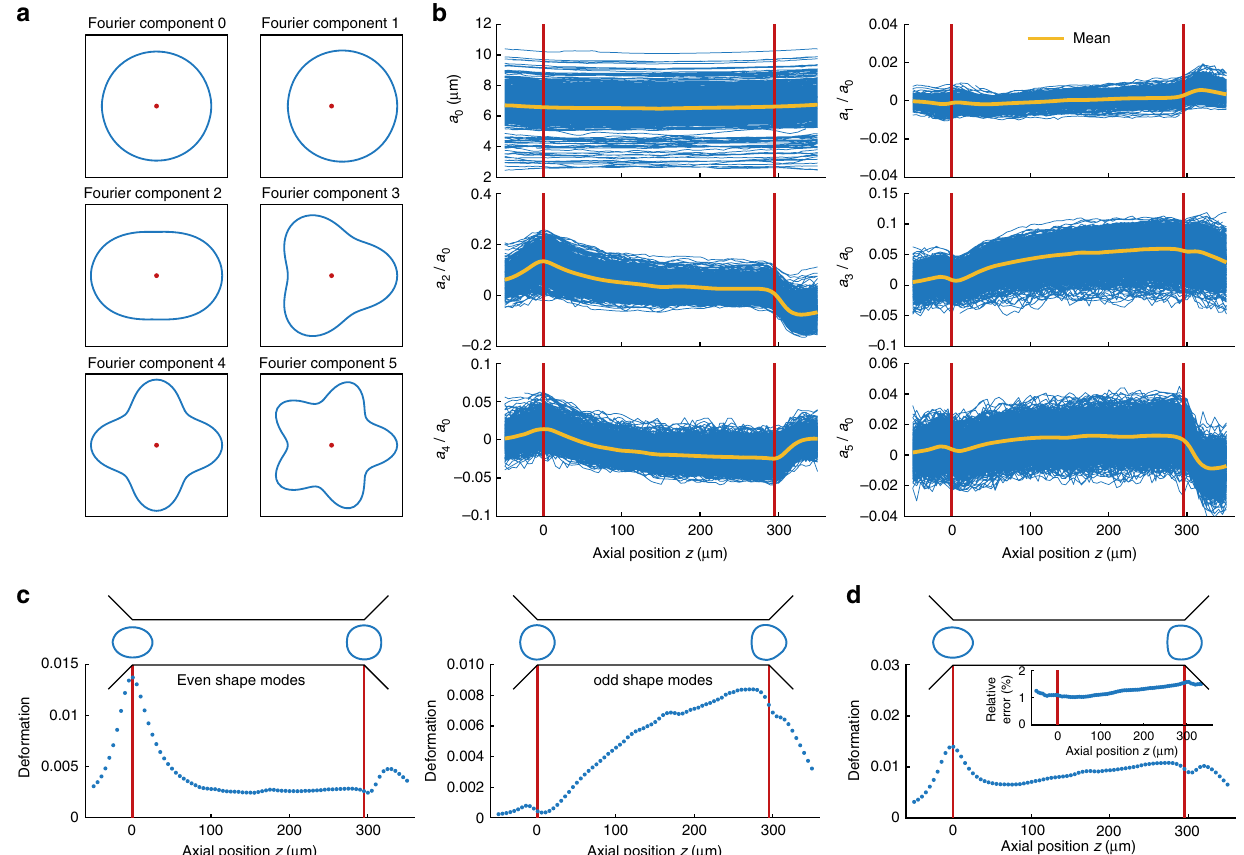
Fig. 2 Fourier decomposition of cell shape. a First six components of radial Fourier function (shape modes) including component zero, red dots indicate the origin. b Shape mode analysis applied to dynamic measurements of HL60 cells arranged for even and odd coef fi cients. Each blue trace represents the amplitude of a Fourier component of a single cell over the axial position z in the channel ( n = 1580 cells). The yellow lines indicate the mean over all traces whereas the red vertical lines visualize the inlet and outlet position. c Reconstruction of cell deformation from fi rst four even (left panel) and fi rst fi ve odd (right panel) Fourier coef fi cients and a 0 with mean cell shapes at channel inlet and outlet (top). d Reconstruction of cell deformation from fi rst ten Fourier coef fi cients, including mean cell shapes (top). Inset shows the relative error in circularity of the reconstructed traces relative to the original dataset. Measurements have been carried out in a 30 × 30 μ m channel at a fl ow rate of 8 nl s −